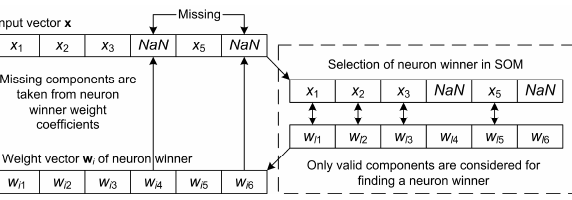
Figure 1. A procedure to restore missing values in input data using